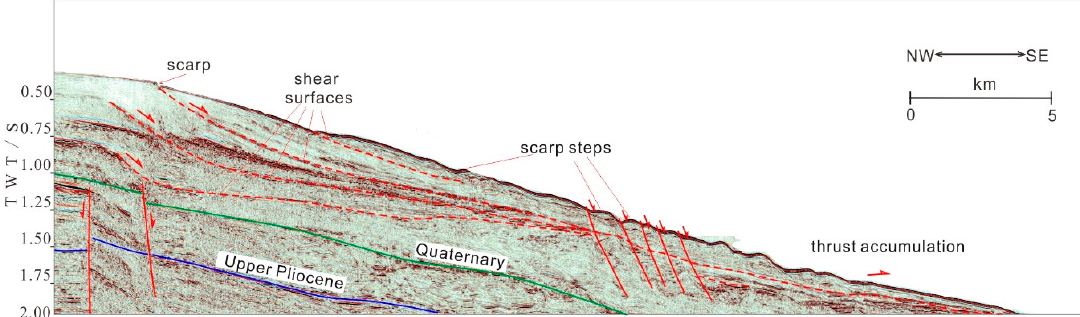
Figure 8. Seismic reflection of Line 7 is a landslide induced by slope breaking.